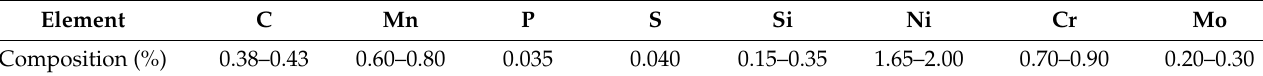
Table 1. Chemical Composition of AISI 4340 Steel [50].